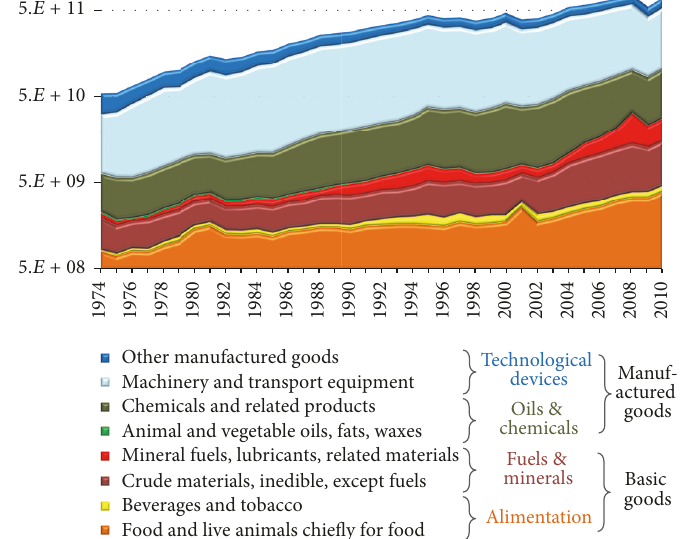
Figure 3: Japan’s export products according to the first-digit classification of Standard International Trade Classification (SITIC), revision 2 for1974–2010innominalvalueUS$(basedon[22–24]).The8mainexportgroupsofthefirst-digitclassificationareaggregatedintotwobinary groupings on higher levels. The highest level distinguishes between basic goods and manufactured goods. Basic goods consist of alimentation and fuels and minerals and manufactured goods of oils and chemicals and manufactured devices (semilog